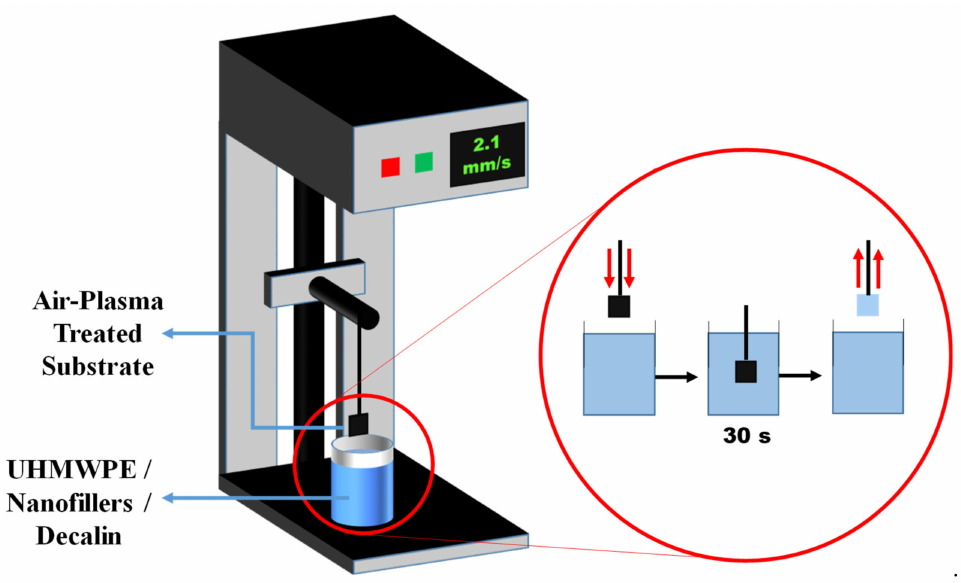
Figure 14. Schematic showing the complete dip coating